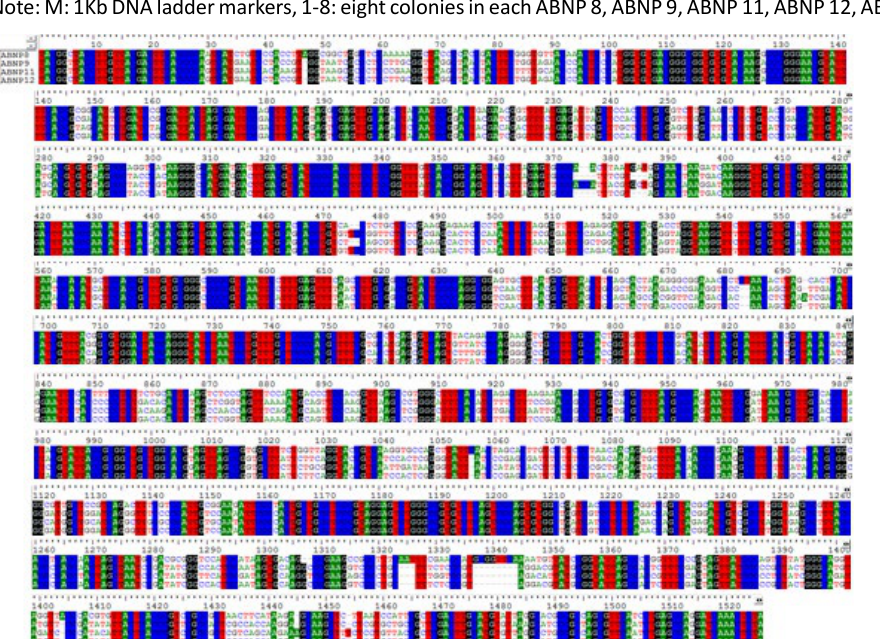
Fig. 3. Results of alignment of five B. thuringiensis local isolates from Auky Island Padaido District in Biak Numfor Papua.